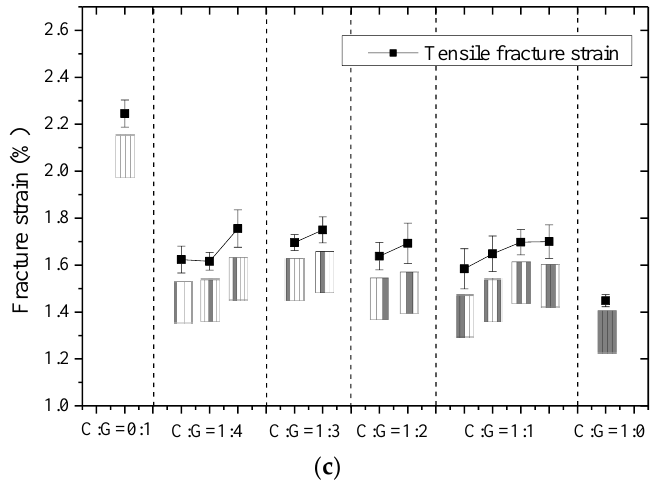
Figure 18. Tensile properties of interlayer hybrid composites with different hybrid ratios and stacking structures: ( a ) tensile modulus; ( b ) tensile strength; ( c ) fracture strain.